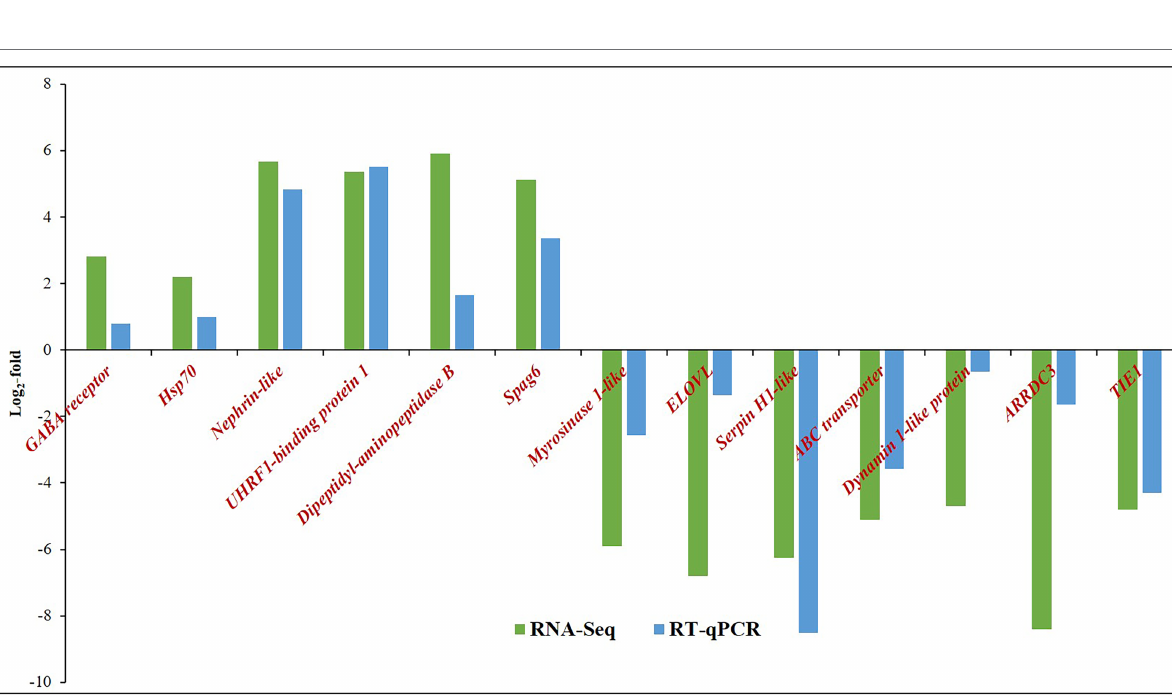
FIGURE 4 | Gene regulatory network (GRN) of DEGs. Red squares represent upregulated DEGs, and blue squares represent downregulated DEGs.